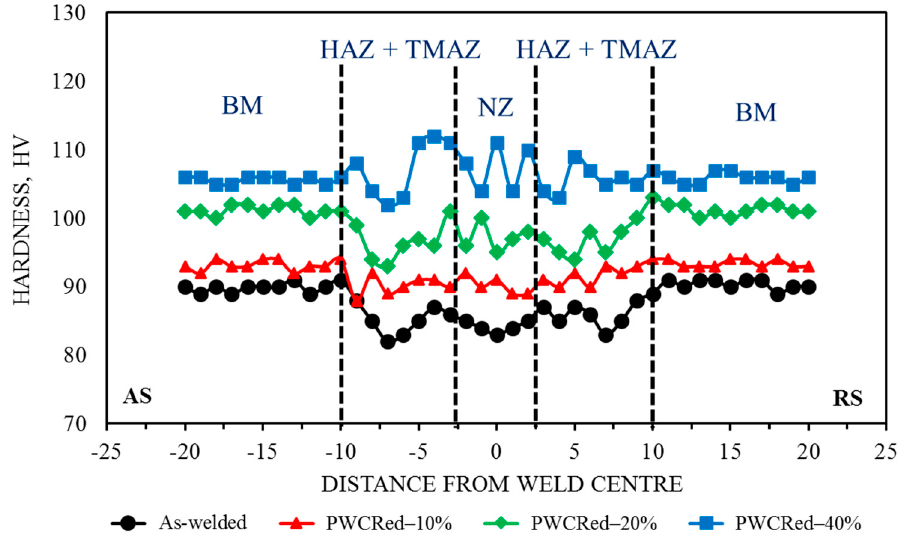
Figure 11. Hardness profile of the as-welded and PWCRed samples. HAZ, heat affected zone; TMAZ, thermomechanically affected zone; BM, base metal.